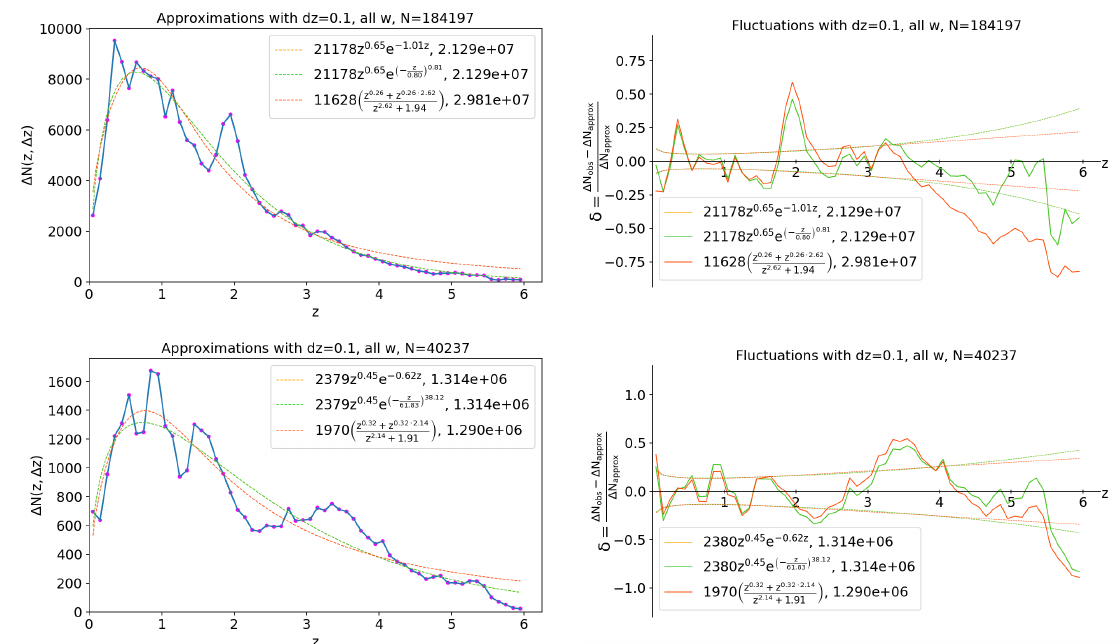
Figure A2. Histograms of radial distribution of the COSMOS2015 photometric redshifts and the corresponding fluctuation patterns for the disjoint COSMOS galaxies ( top ) and UltraVISTA galaxies ( bottom ) with a bin ∆ z = 0.1 and z max = 6 without sampling by σ ( z ) . The dashed lines indicate the least squares fits ( left ) and Poisson noise 5 σ ( right ). Table A1. Tables of structures for disjoint the COSMOS (top) and UltraVISTA (bottom) samples from